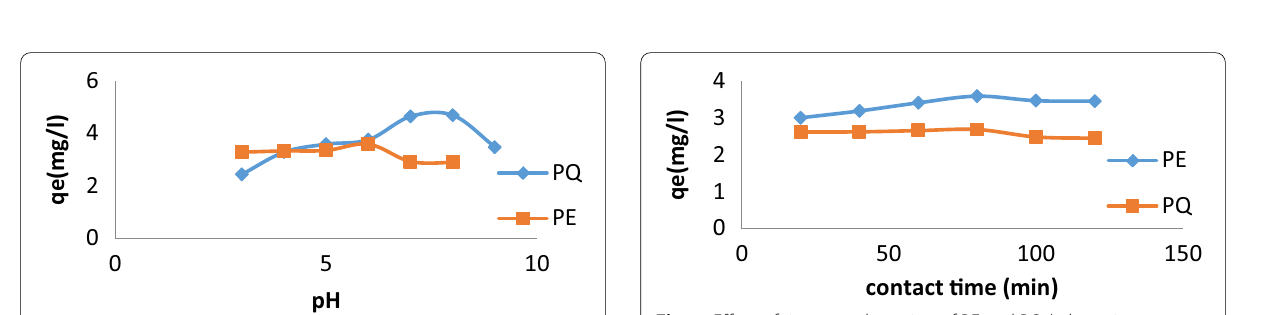
50 mg/l, m 0.1 g, = = 10cm 3 , agitation speed 150 = =